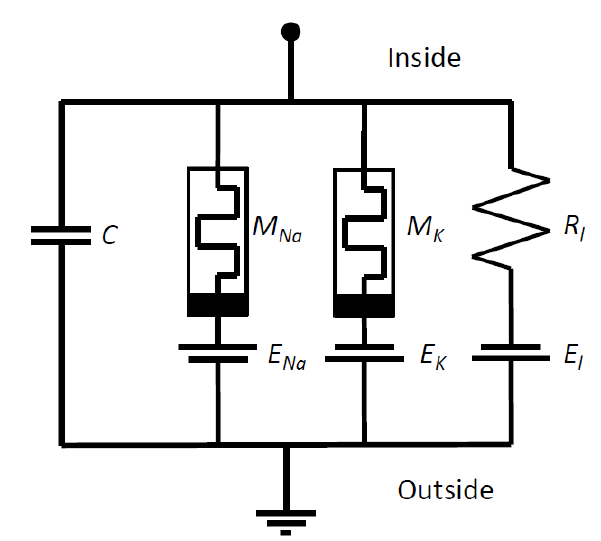
Fig. 10: Memristive Hodgkin-Huxley model. Note that the time- varying resistances in figure 9 are replaced by